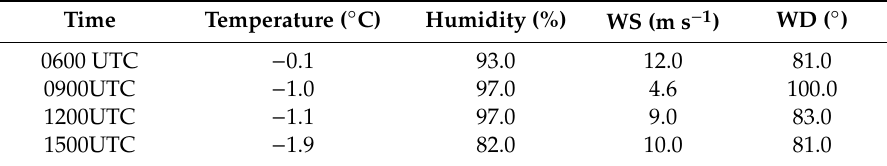
Table 1. Meteorological conditions on 19 March 2018. Listed are the times, temperature, humidity, wind speed (here abbreviated as WS), and wind direction